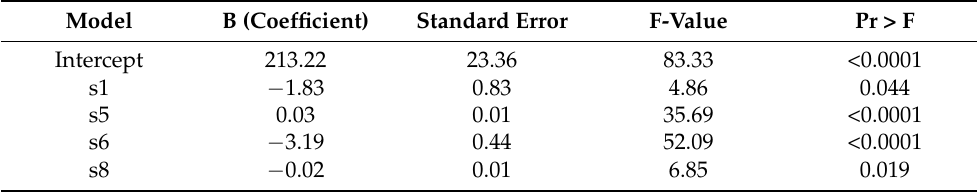
Table 4. Multiple linear regression analysis of pre-anthesis meteorological factors and the 100-grain weight.